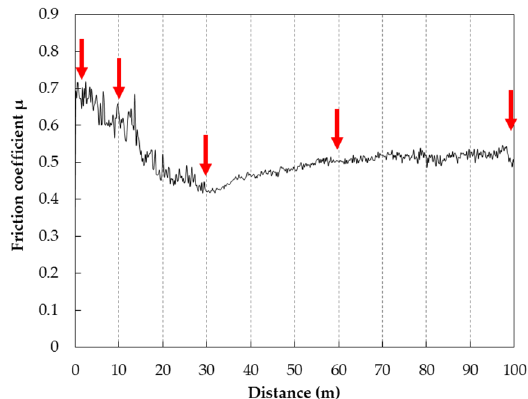
Figure 6. Friction coefficient as a function of sliding distance. Arrows indicate the condition considered for SEM analysis.